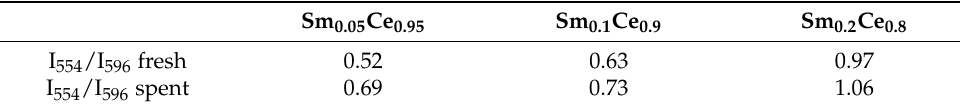
Figure 4. Raman results of fresh and spent catalysts after five cycles of reactions: ( a ) CeO 2 , ( b ) Sm 0.05 Ce 0.95 , ( c ) Sm 0.1 Ce 0.9 , ( d ) Sm 0.2 Ce 0.8 . Table 3. I 554 /I 596 of Raman